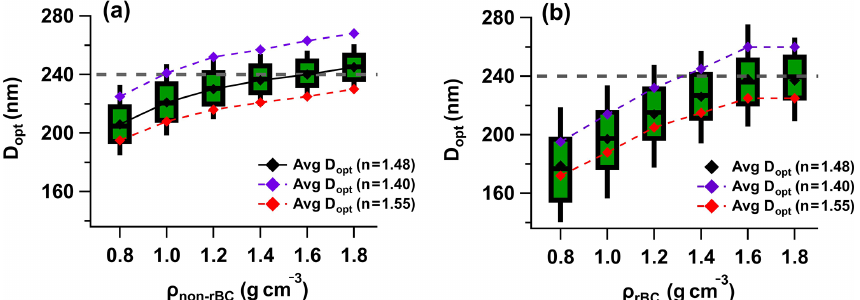
Figure 2. The optical diameters of particles with different effective densities. (a) Non-rBC particles and (b) BC-containing particles. (The black lines in the middle signify the medians; the black markers in the middle denote the means; the upper and lower bounds of the box denote the 75th and 25th percentiles, respectively; and the upper and lower whiskers denote the 90th and 10th percentiles, respectively.) The blue and red dashed lines denote the average optical diameters from different assumptions of the refractive index. The grey dashed line denotes the mobility diameter ( D mob = 240nm) selected by